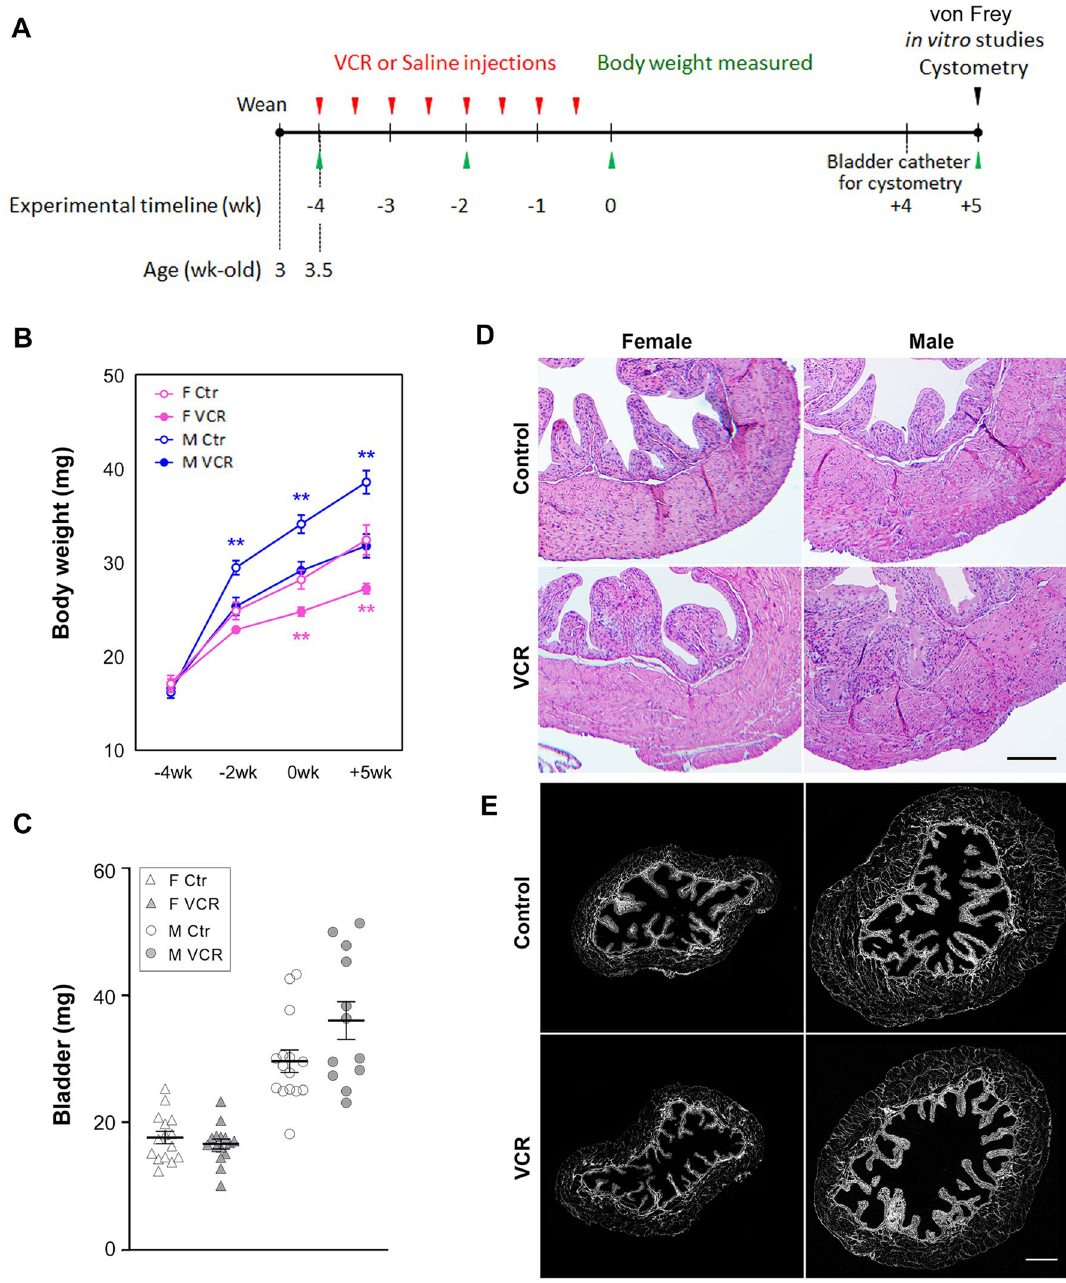
Figure 1. Comparison of changes in body weights, bladder weights and histology between VCR-administered and the control groups. ( A ) experimental timeline. ( B ) body weight was measured on the day before the first (−4wk) and fifth (−2wk) administration, the end of administration cycles (0wk) and 5 weeks after the last, 8th administration. ( C ) bladder weight measured at 5 weeks after the last administration of agents. Open and grey triangles indicate female mice in the control and VCR groups. Open and grey circles indicate male mice in the control and VCR groups [N = 12–15 per group per sex] Mean ± SE. **p < 0.005 vs. the control mice. Representative images of H&E staining ( D ) and collagen distribution (grey) in the bladder by SHG imaging ( E ). Scale bars = 400 µm. Figures were prepared using Adobe Photoshop CS6 and GraphPad Prism 8.4.3 (https:// www. graph pad. com/ scien tific- softw are/